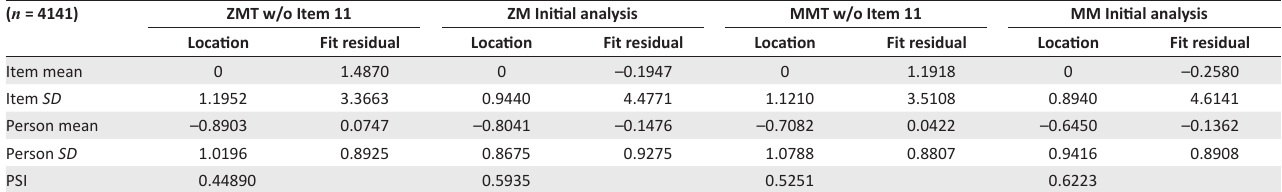
FIGURE 6: Item 2, with item characteristic curve, and multiple choice distractor plot. TABLE 8: Comparison of statistics across tailored